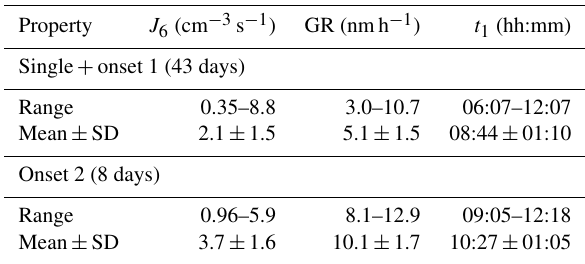
Figure 6. Dynamic properties for the NPF with single start and for the onsets 1 and 2 of the events with double start in the near-city background of Budapest. The data pairs corresponding to the two onsets of an event are indicated by numbers. The data point marked as possible double onset (on 28 April 2012) was assigned to a weak onset 1 and a rather intensive onset 2 by visual inspection although the identification of the two nucleation modes in the size distribu- tions by fitting was not achieved, likely due to the fluctuating data. Table 5. Range of J 6 , GR and starting time t 1 in UTC + 1 together with their mean values and standard deviations (SDs) calculated jointly for the single events and the onset 1 of the NPF events with double start (regional events) and separately for the onset 2 of the events with double start (urban events) in the near-city background of Budapest.